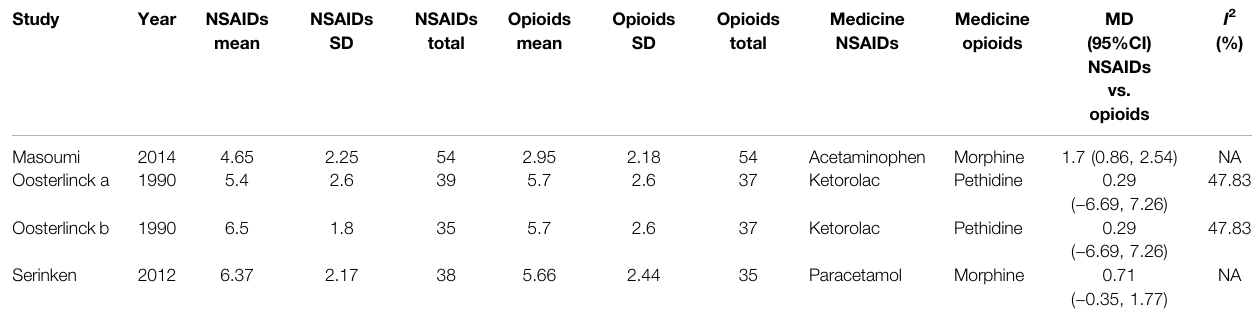
TABLE 3 | Subgroup analysis of NSAIDs and opioids of the changing in VAS at 0 – 30